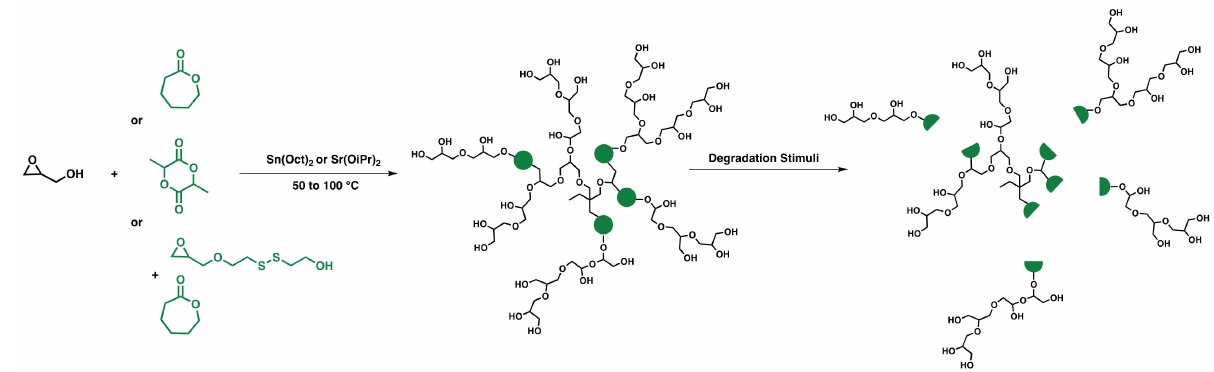
Figure 6. Synthesis of degradable HPG via coordination–insertion mechanism. The degradation follows different stimuli such as changes in pH, reductive environment,